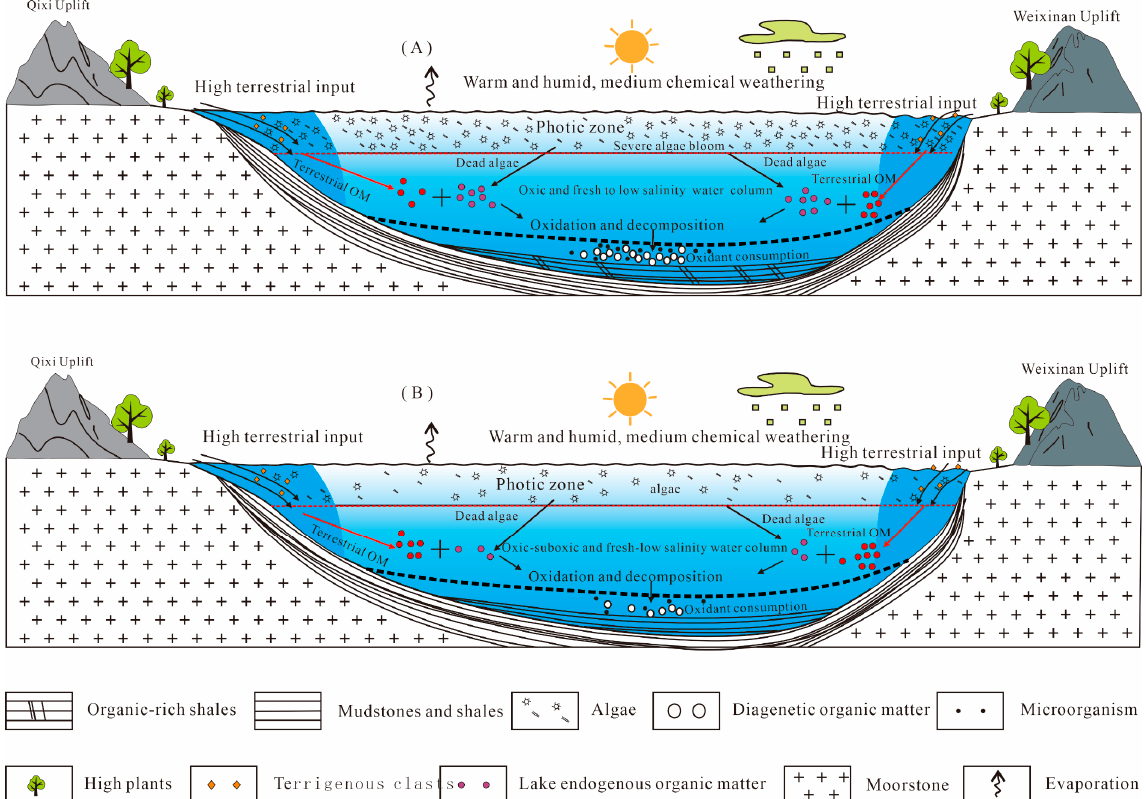
Figure 11. Conceptual diagram along the basin illustrating the factors that in fl uenced the OM enrichment during LS2 of the Weixinan Sag, Beibuwan Basin. ( A ) A high-productivity and oxic to suboxic dynamical formation model, based on the mechanism for the enrichment of OM in organic- rich shales (Model A); ( B ) low-productivity and oxic to sub-oxic dynamical formation model (Model B), based on the mechanism for the enrichment of OM in mudstones and shales.